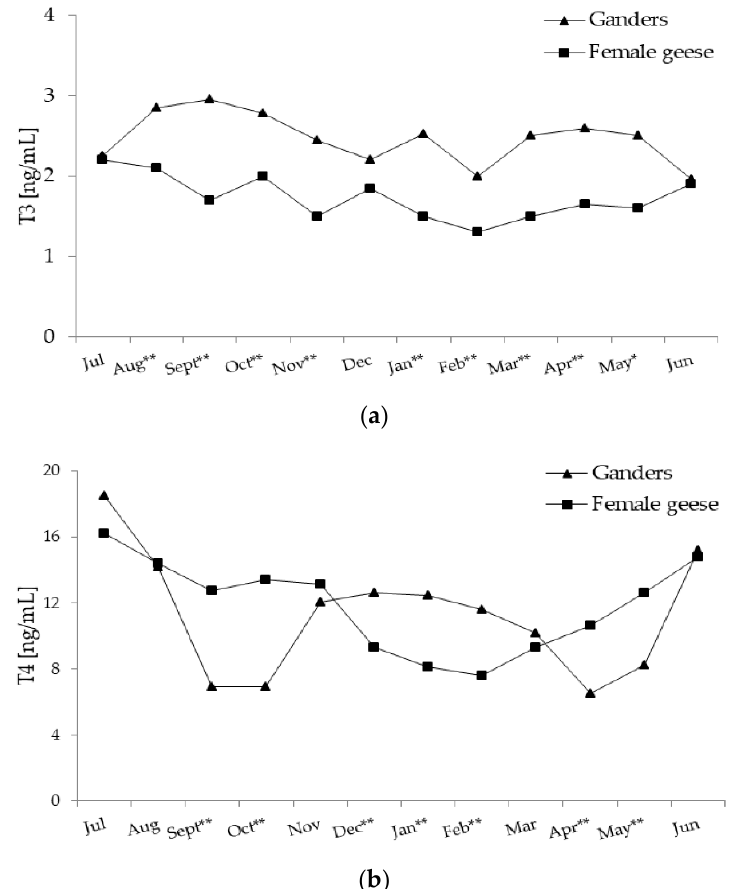
Figure 3. ( a ) Plasma concentration of T3 (tiiodothyronine) in 2-year-old Zatorska ganders ( n = 10) and female geese ( n = 19) during the annual period. Breeding flock (10 ganders and 40 female geese; natural mating). Reproduction period: January–June. Photoperiod during reproduction: short-day (SD) 10L:14D. Data are means presented in monthly intervals. Annual pattern of T3 in ganders fit a linear trend ( p < 0.01) and in female geese random fluctuation (no trend) was noted. The months with different superscripts indicate significant differences between means for sex—ganders vs. female